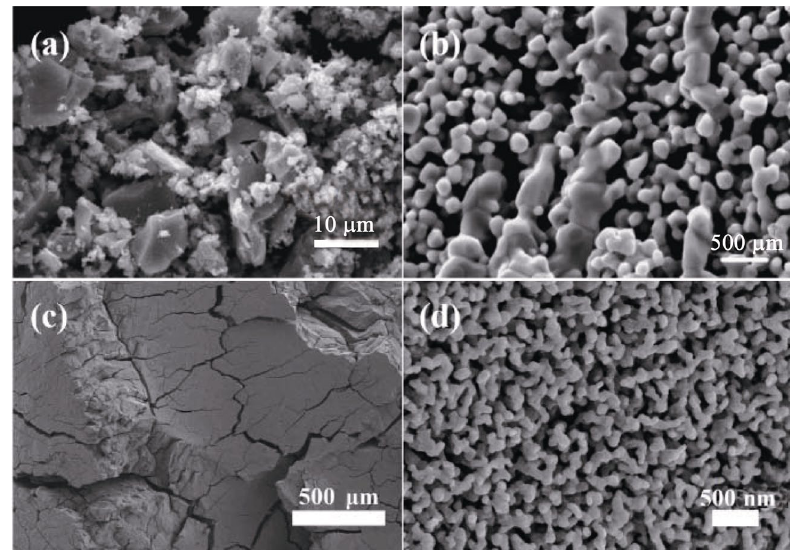
Fig. 1 SEM images of sol–gel derived ZrC powders heated (a) at 1600 ℃ for 3 h and (b) at 1400 ℃ for 2.5 h then at 1800 ℃ for 6 min. Reproduced with permission from Ref. [41], © Elsevier Ltd. 2006. (c) Low and (b) high magnification SEM images of sol–gel derived ZrC/SiC composite heated at 1500 ℃ for 1 h [49]. Reproduced with permission from Ref. [49], © Springer Science+Business Media, LLC, part of Springer Nature